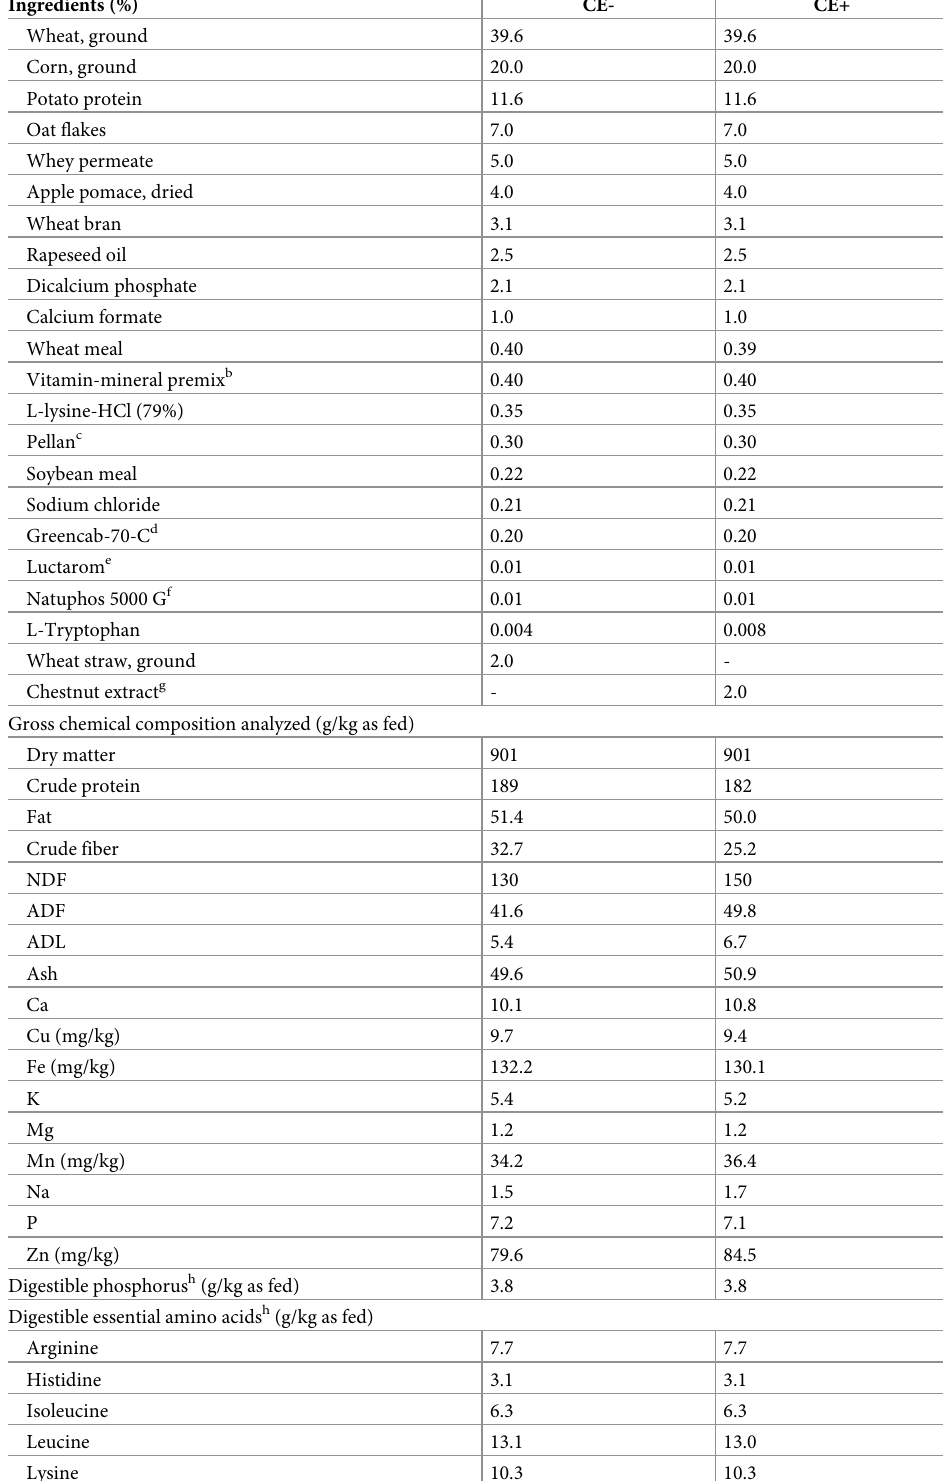
Table 1. Composition (%) and gross chemical content (g/kg as fed) of the piglets experimental diets a